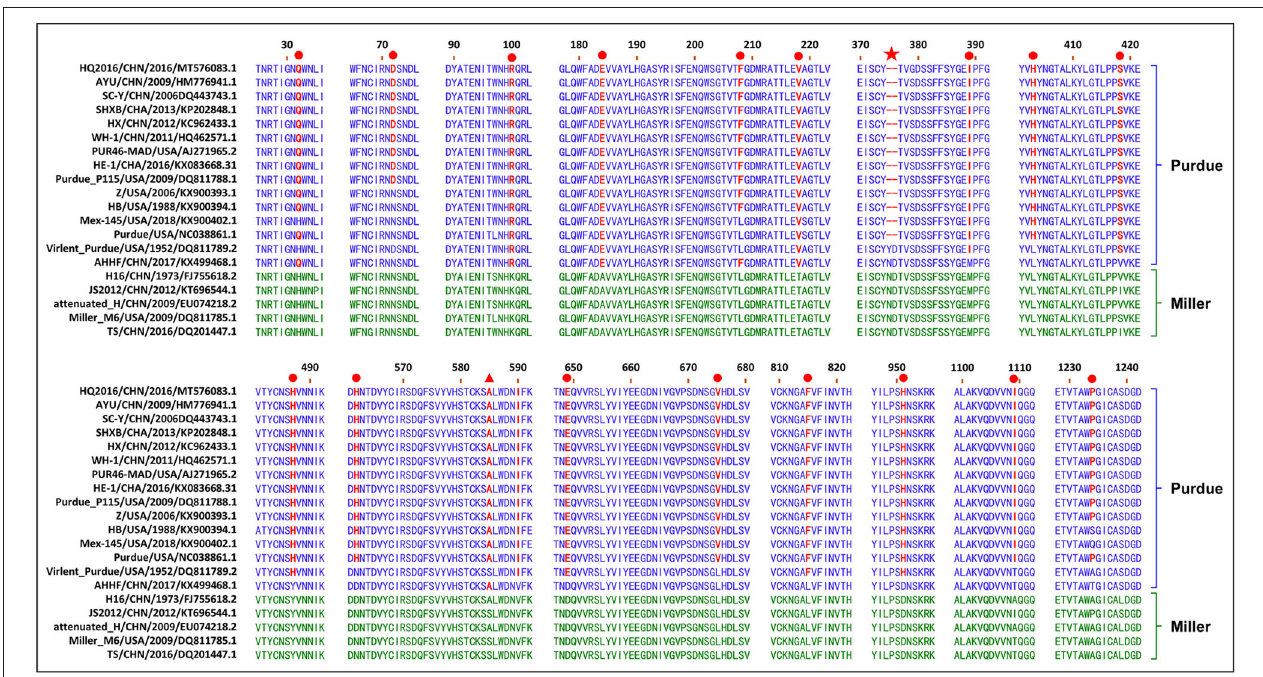
FIGURE 3 | Alignment of partial deduced amino acid sequence of S protein compared with strain TGEV HQ2016. ( N ) indicates amino acid 585, ( ⋆ ) indicates 6-nt deletion in the S gene, (•) indicates amino acids of the Purdue subgroup strains include TGEV HQ2016 are different from those of Miller subgroups strains.